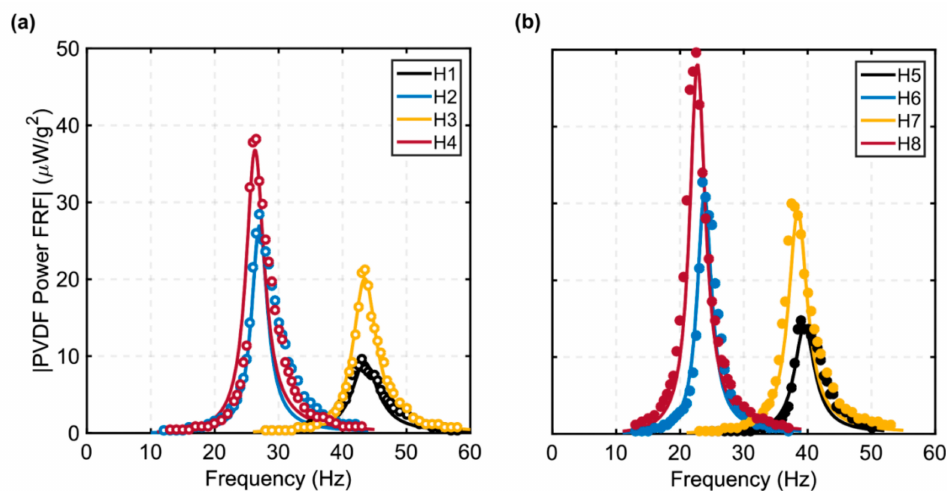
Figure 5. Measured and predicted power output FRFs for the PVDF elements of the eight harvesters. ( a ) Harvesters without solar panels (empty circle markers). ( b ) Harvesters with solar panels (filled circle markers). Markers represent the experimental measurements whereas solid lines represent equivalent concentrated tip mass model